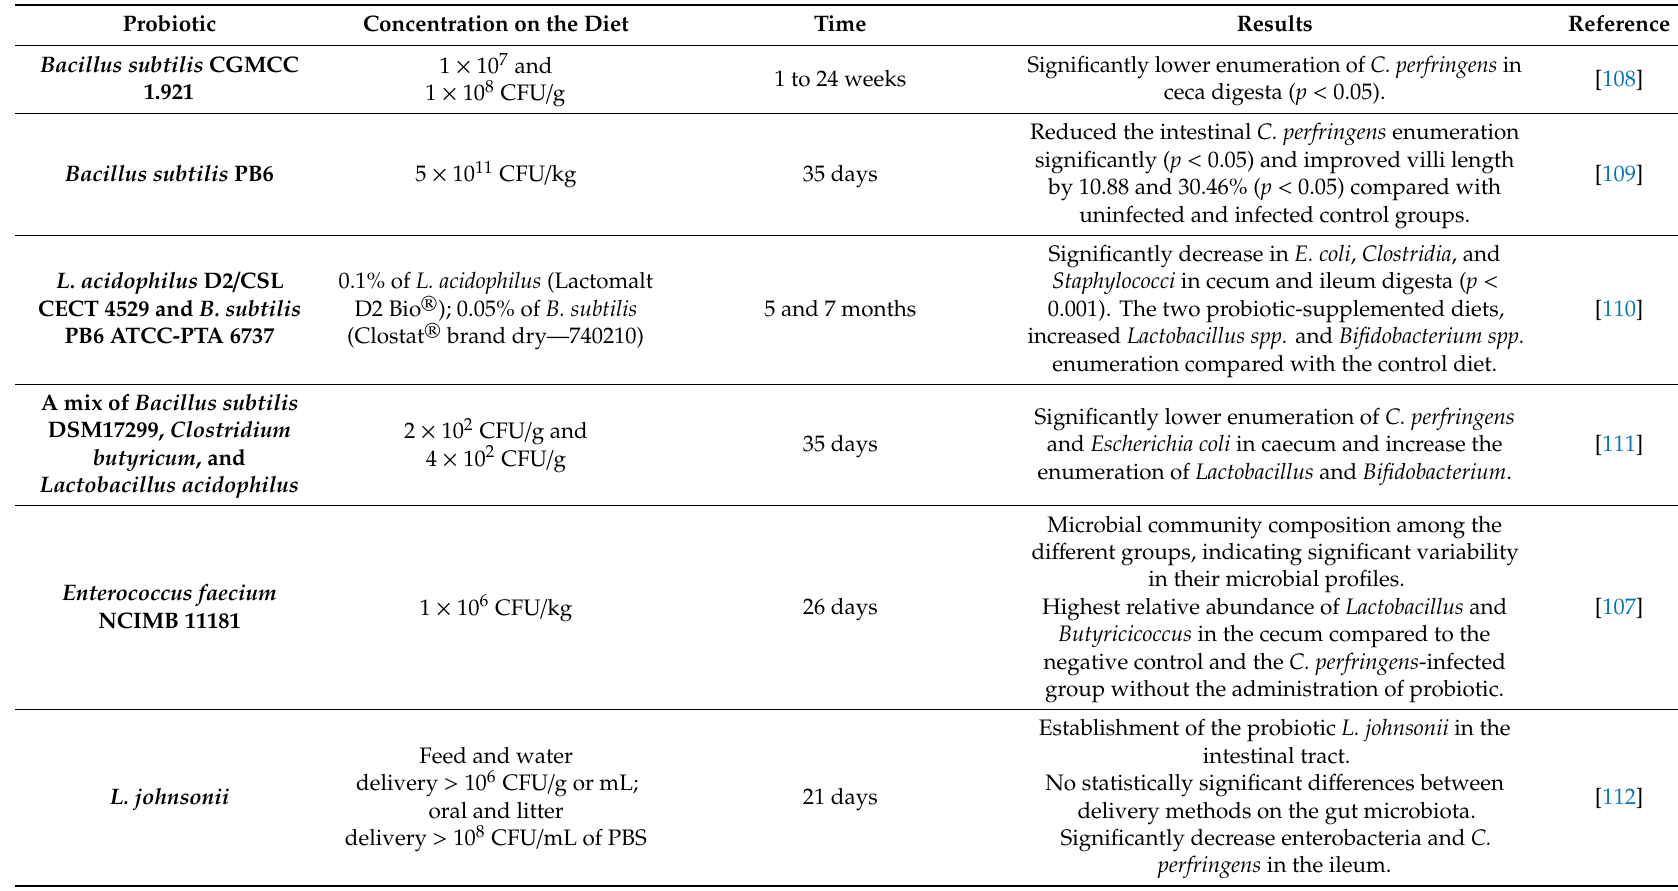
Table 6. Probiotic strains used for microbiota modulation to control necrotic enteritis caused by Clostridium perfringens in broiler